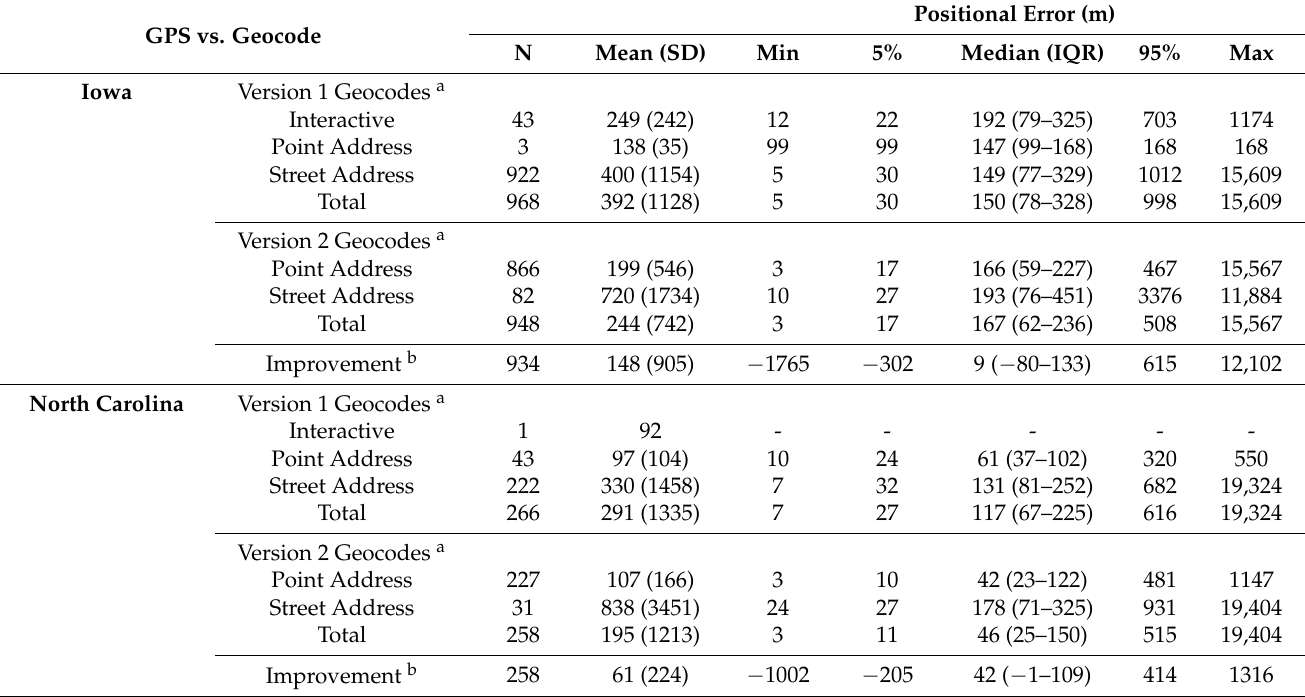
Table 4. Positional error (m) of Version 1 and Version 2 geocodes compared to Global Positioning System (GPS) coordinates for Iowa and North Carolina participants by geocode match status. GPS vs.